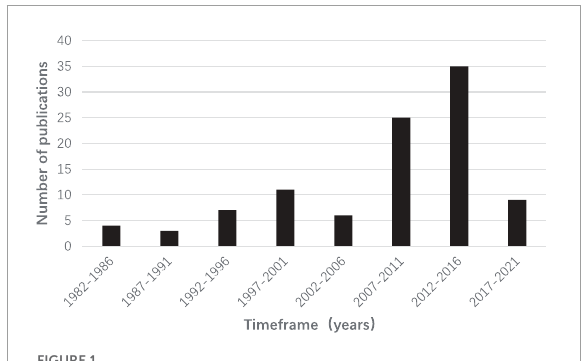
FIGURE1 A bar graph showing the time frame of publication and number of publications per time frame for the top 100 most-cited reports on hidradenitis suppurativa.